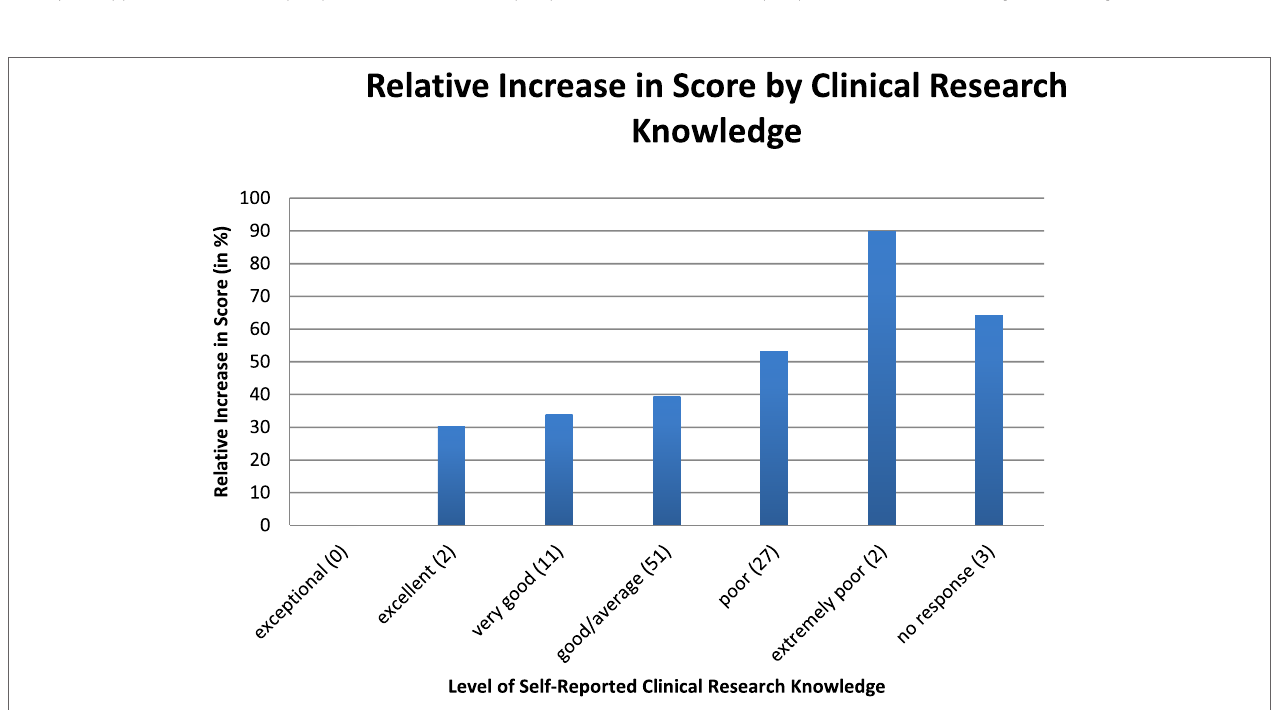
FigUre 4 | Relative increase in scores from pre-course to post-course questionnaire by level of self-reported clinical research knowledge.